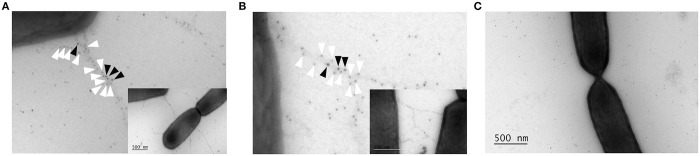
Immunogold labeling reveals colocalization of SpaA and fucose on SpaCBA pili.Immunoelectron microscopy double labeling of L. rhamnosus GG cells (A and B) and the ΔspaCBA::TcR mutant (CMPG5357) (C) with SpaA antiserum and the fucose-specific Aleuria aurantia lectin (AAL). Detection of SpaA and AAL was done using 5 nm (white arrows) and 10 nm gold particles (black arrows) respectively. The scale bar represents 500 nm. Original overall pictures are shown as insets of A and B.